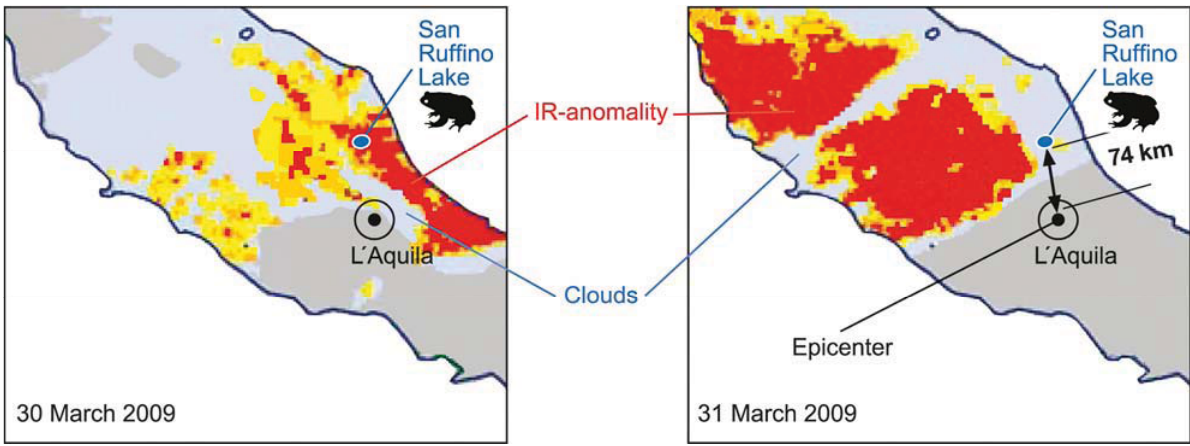
Figure 6. Infrared anomaly seen from a satellite (infrared anomaly distribution adapted from [48]) over central Italy before the Abruzzo earthquake. The left image was taken on 30 March, the right one on 31 March (the quake happened on 6 April, 3.32 A.M.). The arrows in the figures indicate the site of animal (toad) observation and the epicentre respectively (the infrared absorbing clouds are also